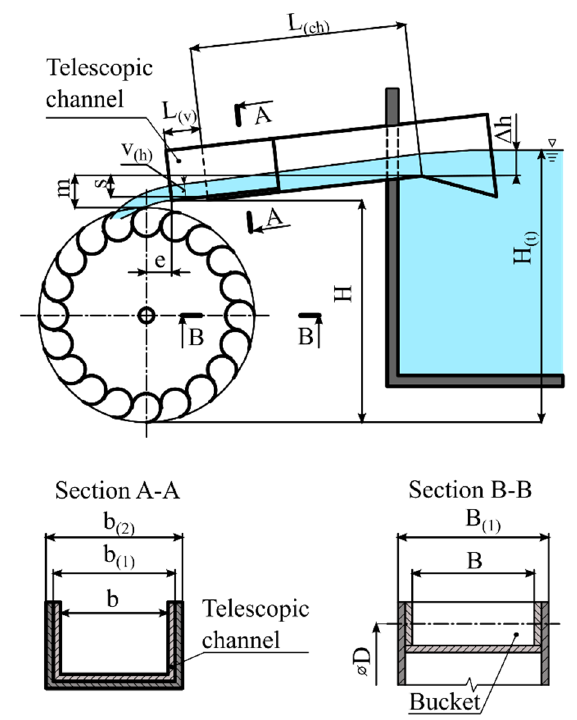
Fig. 2. Experiment layout .